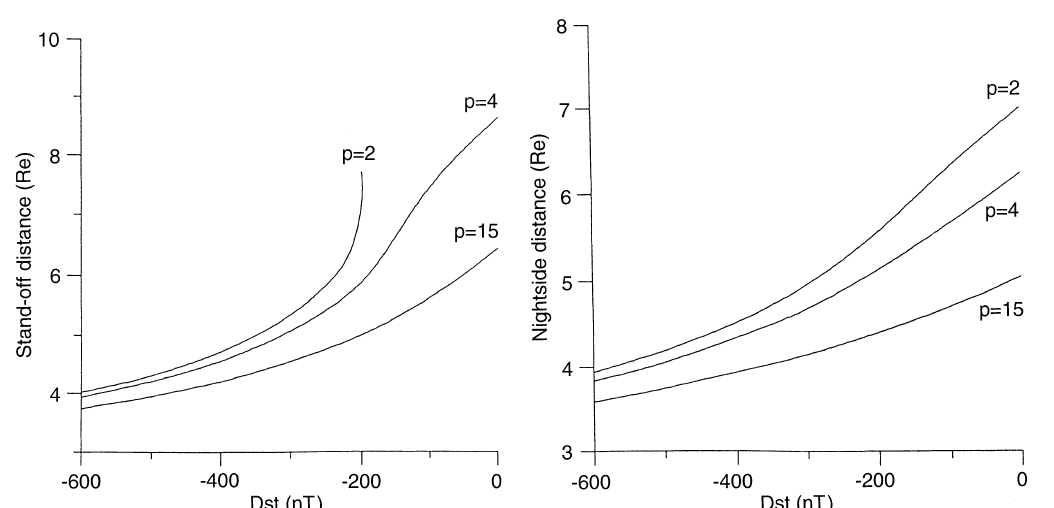
Fig. 1. Dependence of the geocentric distance to the contour B (cid:136) B s at noon ( left panel ) and midnight ( right panel ) on the Dst index for three values of the solar wind dynamic pressure